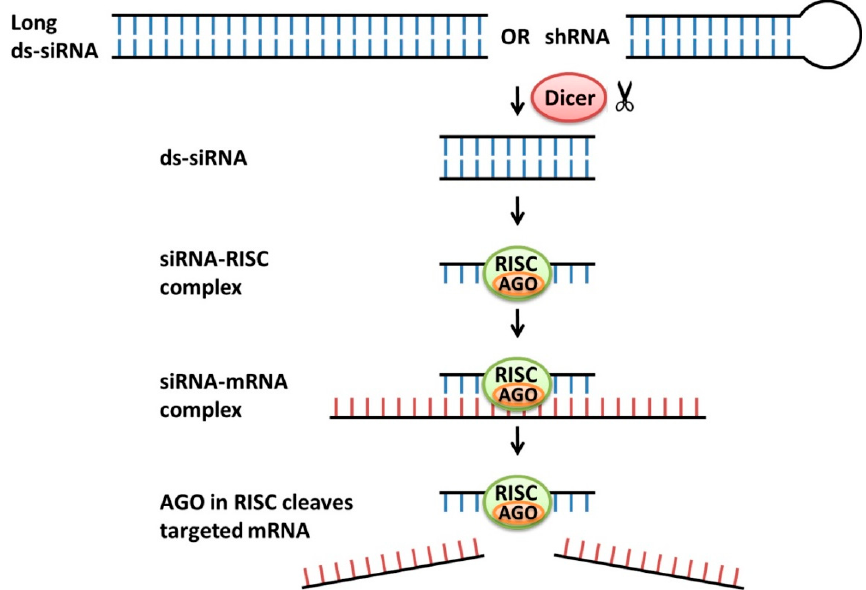
Figure 3. Mechanisms of actions of siRNAs . Long double-stranded RNA (Long ds-RNA) or short hairpin RNA (shRNA) is processed and cleaved into a 20–30 bp double-stranded siRNA (ds-RNA) by RNase Dicer. In cell cytoplasm, the antisense strand of an siRNA binds to the endogenous RNA-induced silencing complex (RISC), whereas the sense strand of the siRNA is discarded. The antisense strand guides RISC to recognize target mRNA through base-pair complementary binding. The endonuclease Argonaute 2 (AGO) in the RISC complex enzymatically cleaves the target mRNA, leading to target gene knockdown.